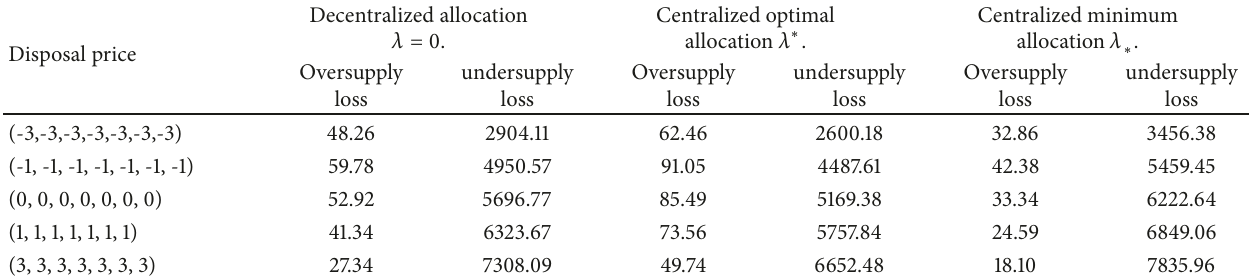
Centralized optimal allocation 𝜆 ∗